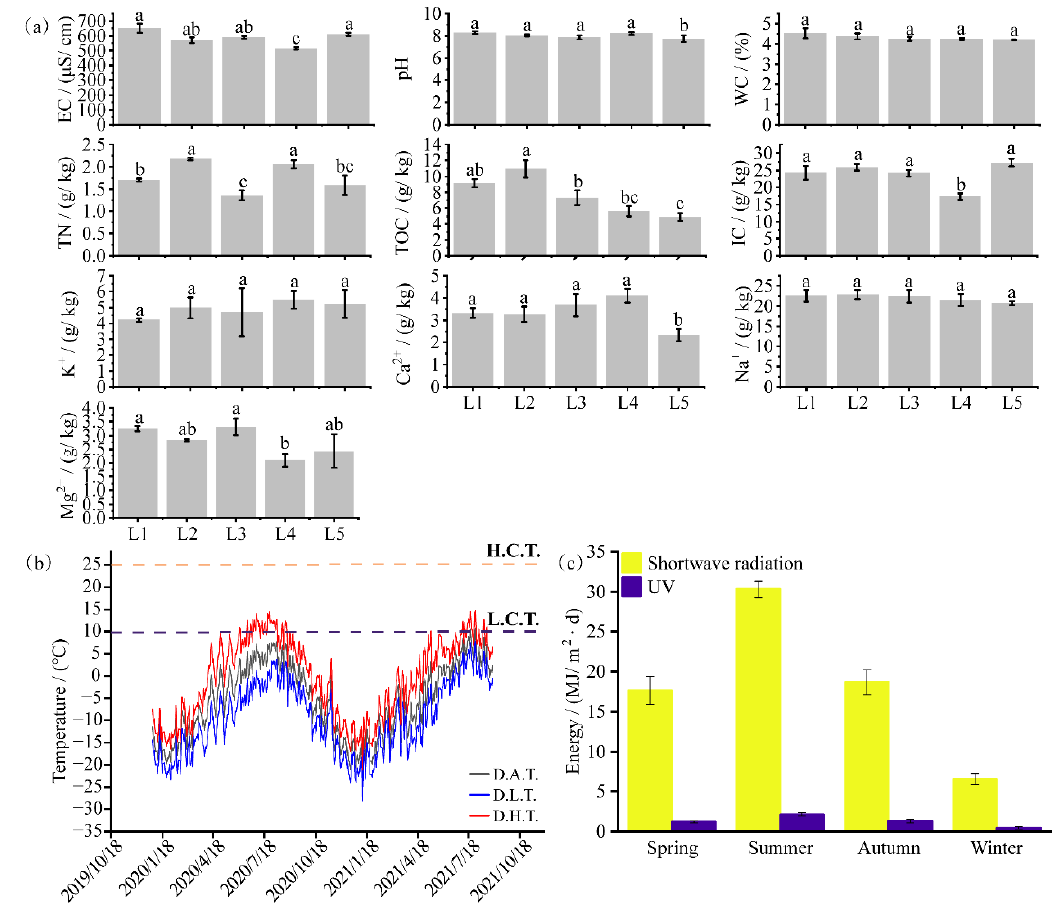
Figure 2. Characteristics of environmental factors in the study region. ( a ) Physicochemical properties of soil samples collected from the moraine. ( b ) Temperature changes. D.A.T., D.L.T., and D.H.T. represent the daily average temperature, daily lowest temperature, and daily highest temperature, respectively. H.C.T. and L.C.T. represent the highest culture temperature and the lowest culture temperature, respectively. ( c ) Characteristics of seasonal radiation changes in the study region. Different letters over the bars in ( a ) indicate significant differences in Physicochemical indicators at different sites.